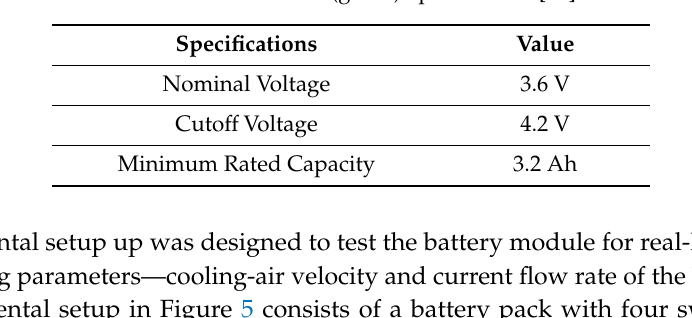
Figure 4. Battery module investigated. Table 1. NCR18650B (green) Specification [13] .